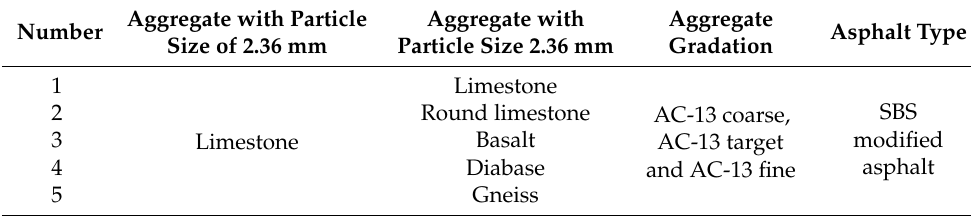
Table 1. Test program.